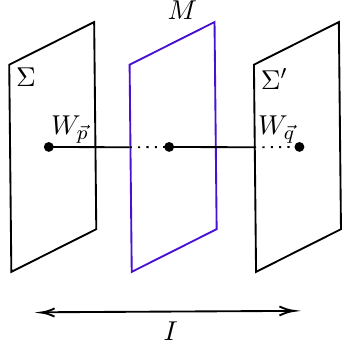
Figure 1 . The pairing of 2d CFT left and right movers on Σ and Σ 0 can be specified by an abelian CS theory on X ' Σ × I with a surface operator, M , inserted in between [12, 13]. A local operator, , is specified by the Wilson lines W and W . Different M lead to different partition functions. O ~p ~q ( ~p,~q ) Topological defects in the 2d CFT correspond to Wilson lines parallel to Σ , Σ 0 (see figure 2).